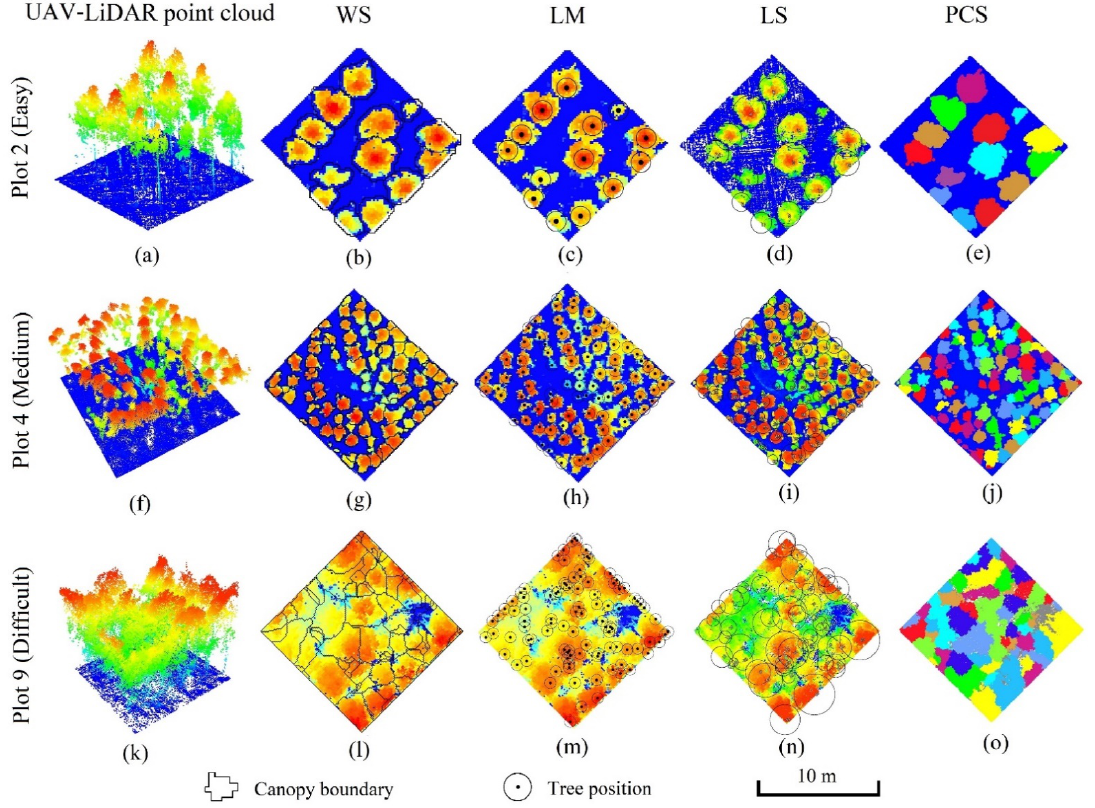
Figure 4. The individual tree segmentation performance in some plots. ( a , f , k ) are the UAV-LiDAR point clouds in plot 2, plot 4 and plot 9, respectively; ( b , g , l ) are the CHMs after WA segmentation; ( c , h , m ) are the CHMs after LM segmentation; ( d , i , n ) are the CHMs after LS segmentation; and ( e , j , o ) are the CHMs after PCS.